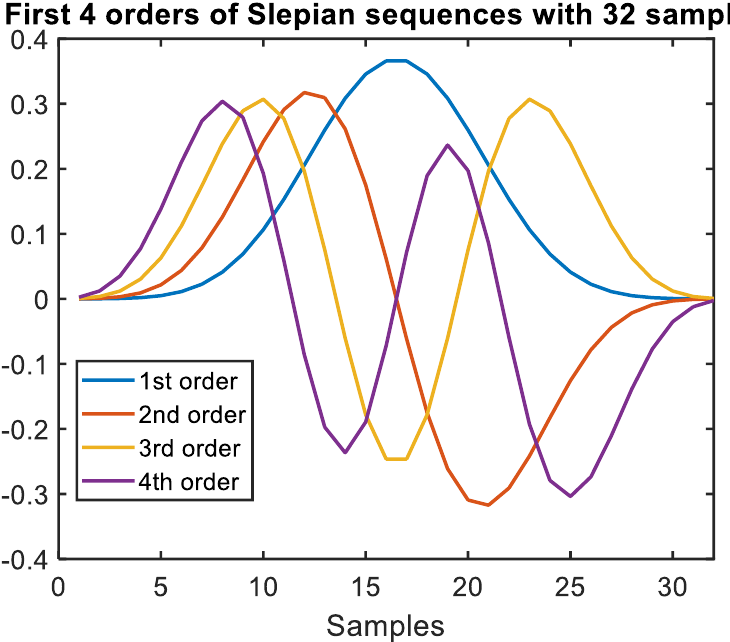
Figure 1. Different orders of Slepian sequences with 32 samples/waveform used in experimental verification.